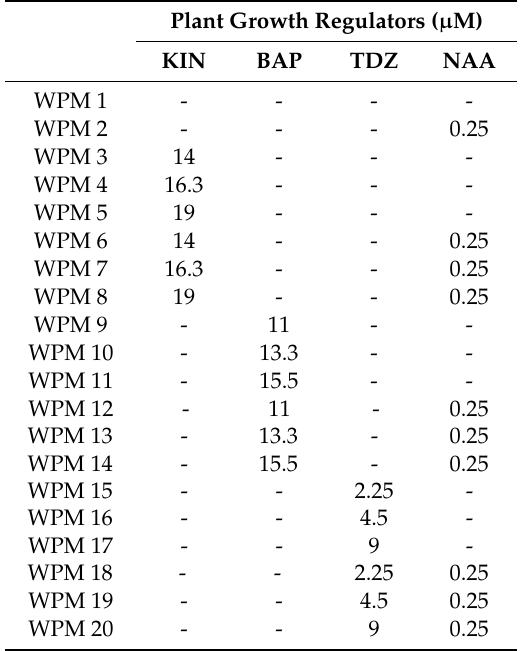
Table 3. Di ff erent concentrations and combinations of PGRs used in the regeneration